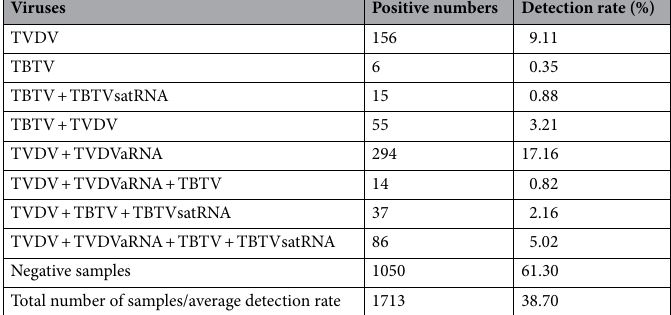
Table 9. Detection of the four TBTD causal viruses in field collected